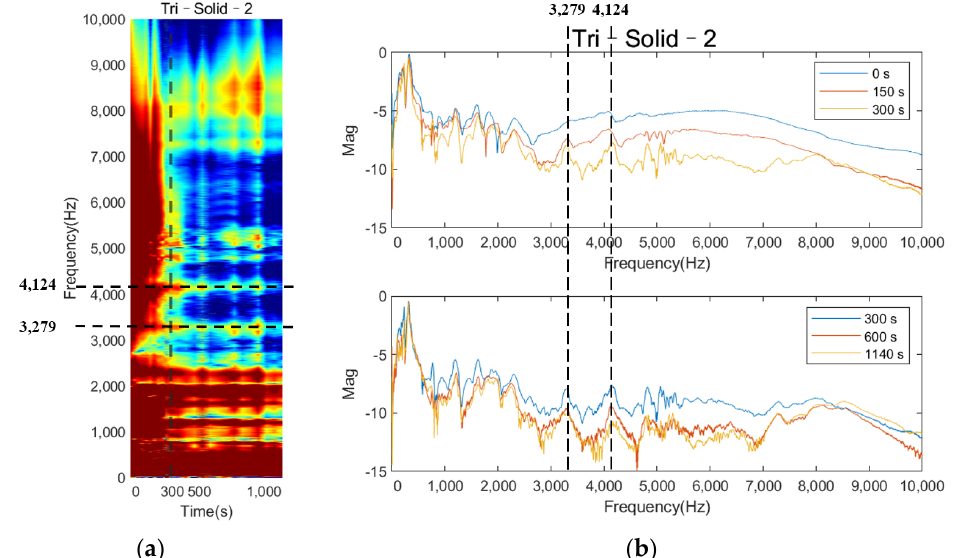
Figure 7. Plots of ( a ) colormap based on normalized magnitude development as the function of cure time, ( b ) cross–spectrum at five different cure times.